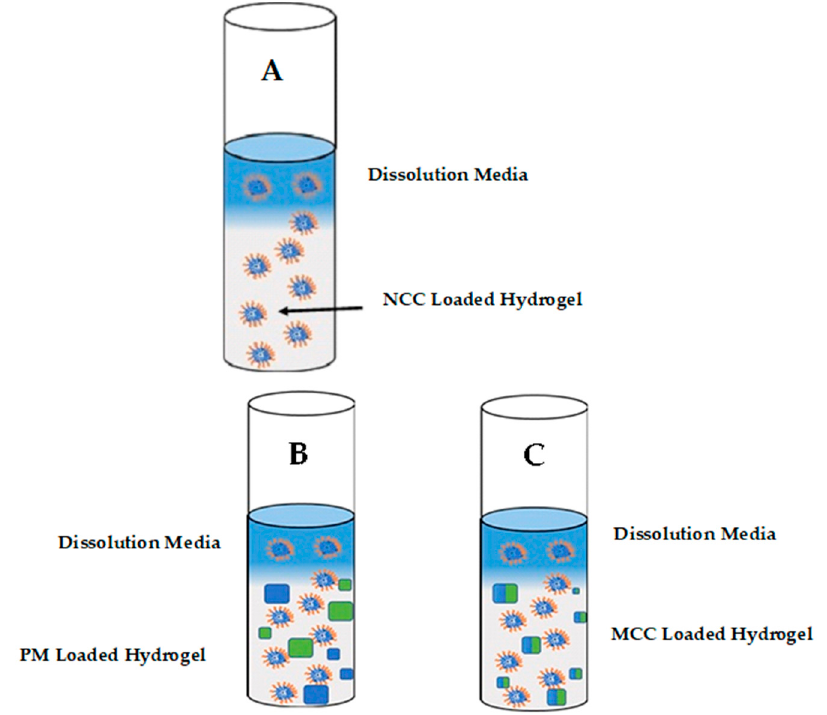
Figure 5. Schematic representation of 3TC and AZT release from ( A ) NCC ( B ) physical mixture (PM) and ( C ) MCC-loaded hydrogels.